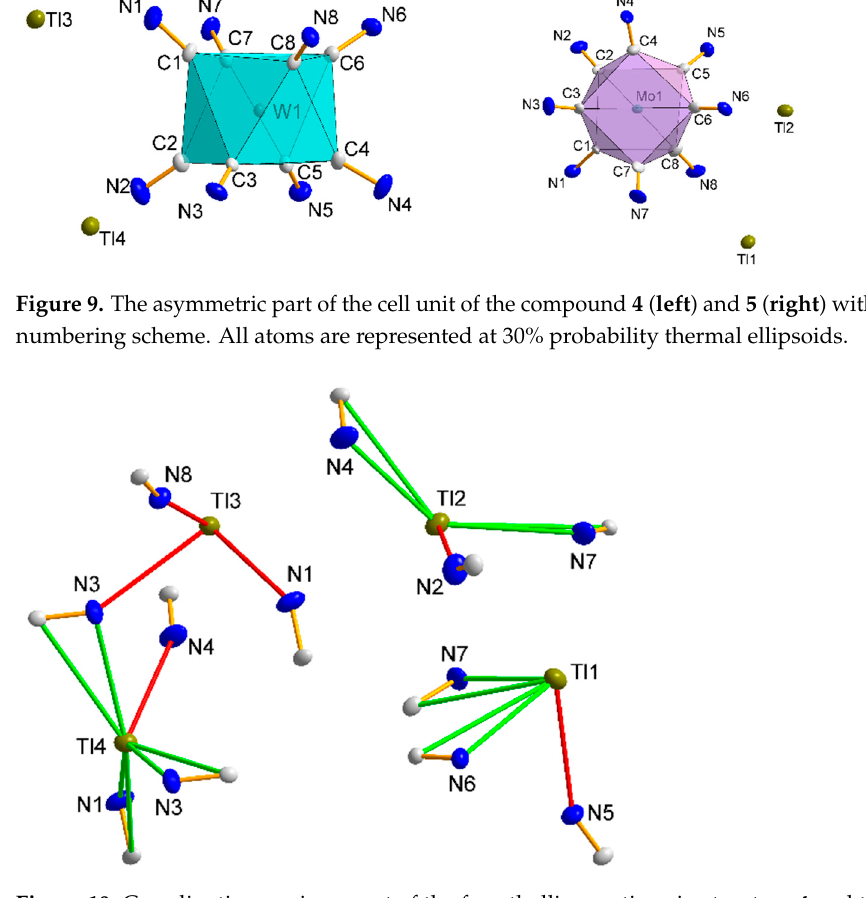
Figure 10. Coordination environment of the four thallium cations in structure 4 and their different bridging modes by cyanido ligands. “Side-on” bridging interactions are shown in green, and “end-on” interactions in red. All atoms shown are represented on thermal ellipsoids with a probability of 30%.